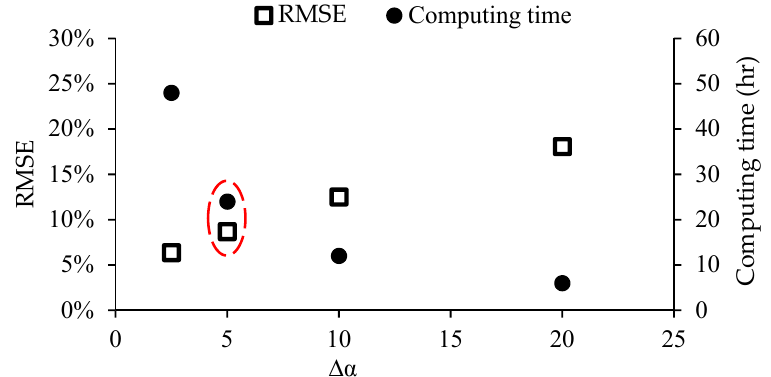
Figure 9. RMSE values and computing costs for different angle steps.